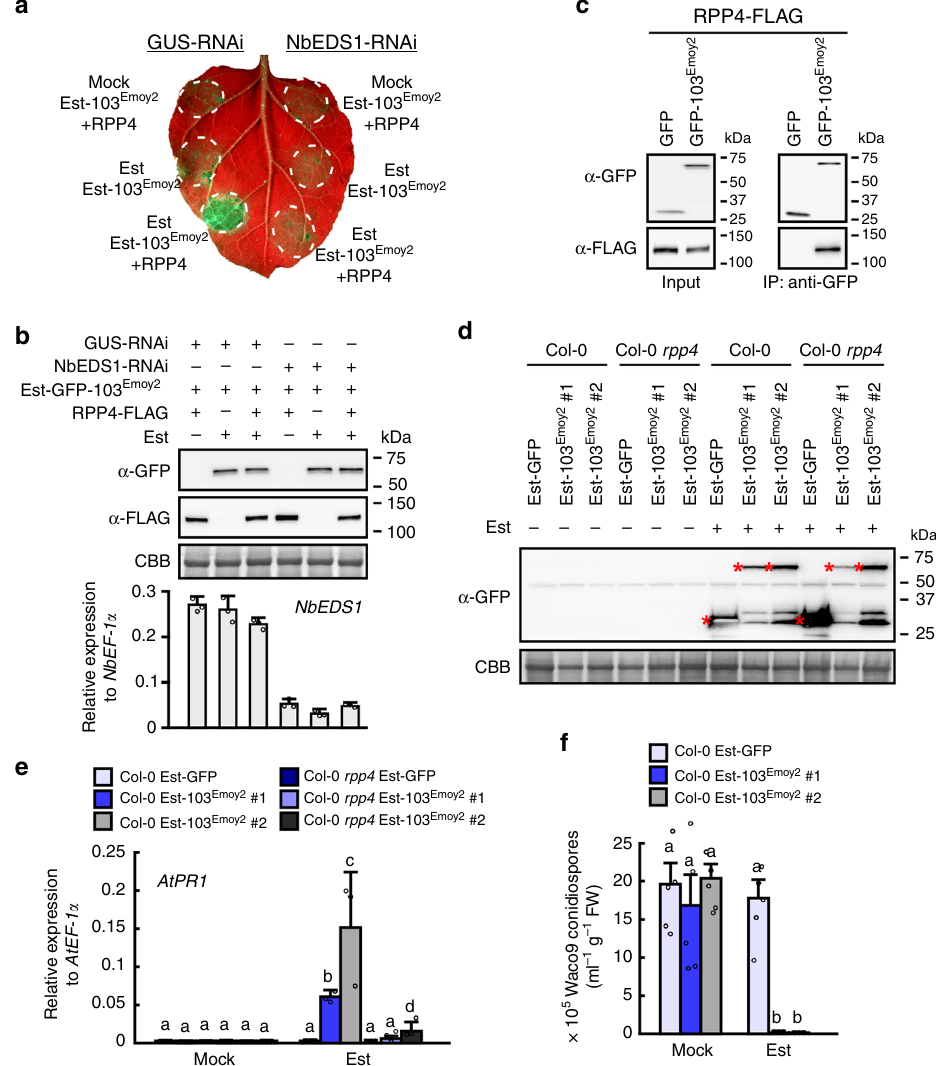
Fig. 2 HaRxL103 Emoy2 is recognized by RPP4 in an EDS1 -dependent manner. a N. benthamiana leaves were inoculated with Agrobacterium containing estradiol-inducible GFP-HaRxL103 Emoy2 (Est-103 Emoy2 ), RPP4-FLAG and GUS-RNAi or NbEDS1-RNAi constructs. The different inoculation sites were in fi ltrated with 20 μ M estradiol (Est) or water (Mock) 24 h after the inoculation. The leaves were photographed under UV at 2 days after the in fi ltration. b Con fi rmation of proteins accumulation and NbEDS1 silencing. Total proteins and RNAs were prepared from N. benthamiana leaves described above 8 h after in fi ltration with estradiol or water. Immunoblot analyses were done using anti-GFP (top panel) and anti-FLAG (middle panel) antibodies. Protein loads were monitored by Coomassie Brilliant Blue (CBB) staining of the bands corresponding to ribulose-1,5-bisphosphate carboxylase (Rubisco) large subunit (bottom panel). The bar chart indicates expression levels of NbEDS1 determined by qRT-PCR. Data are means ± SDs from three technical replicates. The experiments were repeated two times with similar results. c In planta interaction between HaRxL103 Emoy2 and RPP4. Co-immunoprecipitation was performed with extracts from N. benthamiana leaves co-expressing GFP or GFP-HaRxL103 Emoy2 with RPP4-FLAG. MACS MicroBeads with GFP antibody were used for immunoprecipitation, and anti-GFP (upper panel) and anti-FLAG (lower panel) antibodies were used to detect the related proteins in the immunoprecipitates. Protein accumulation ( d ), AtPR1 expression ( e ), and Hpa growth ( f ) in Arabidopsis Col-0 and Col-0 rpp4 transgenic lines containing estradiol-inducible GFP (Est-GFP) and Est-103 Emoy2 constructs. d Total proteins and RNAs were prepared from 2-week old plants 24 h after spray treatment with 40 μ M estradiol or water. Immunoblot analyses were done using anti-GFP as described in ( b ). Asterisks indicate the detected GFP or GFP- HaRxL103 Emoy2 constructs. e The expression level of AtPR1 was determined by qRT-PCR. Data are means ± SDs from three biological replicates. Different letters indicate signi fi cantly different values at p < 0.05 (one-way ANOVA, Tukey ’ s HSD). f Three-week-old transgenic lines 24 h after spray treatment with estradiol or water were inoculated with Hpa Waco9. Conidiospores were harvested and counted at 5 dpi. Data are means ± SEs from fi ve biological replicates. Different letters indicate signi fi cantly different values at p < 0.01 (one-way ANOVA, Tukey ’ s